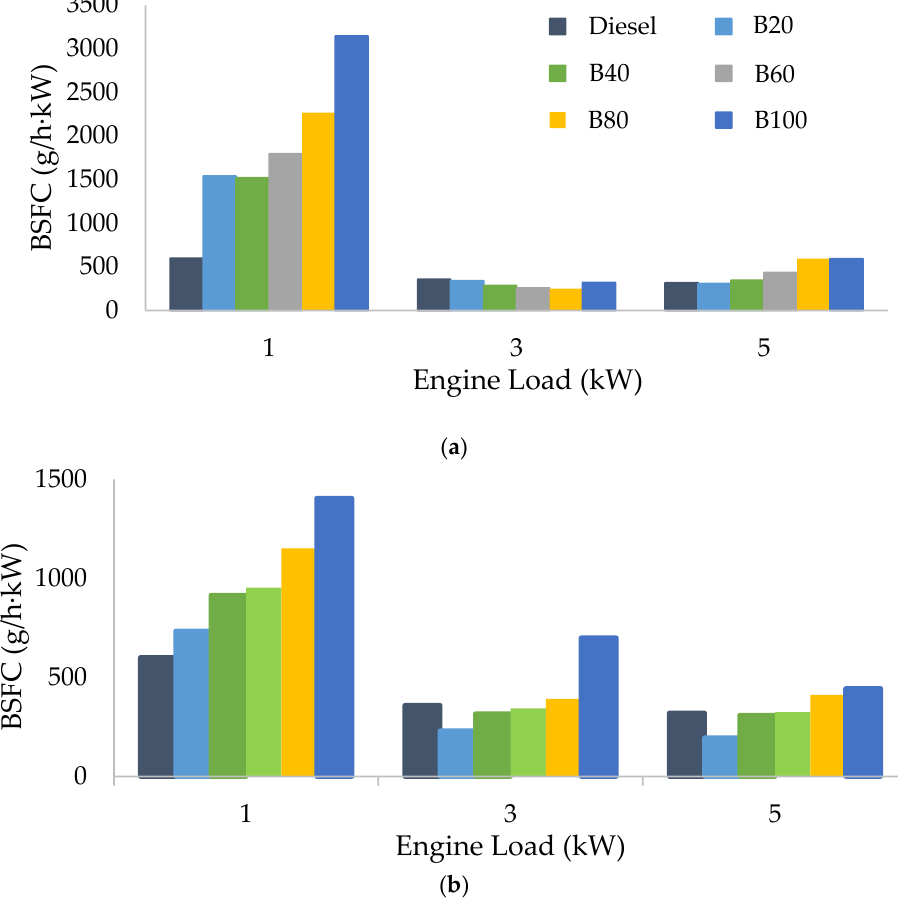
Figure 4. Effect of ( a ) ABE/SO and ( b ) ABE/CO biofuels on BSFC (g/h·kW) at low, medium, and high engine loads (1, 3, 5 kW).